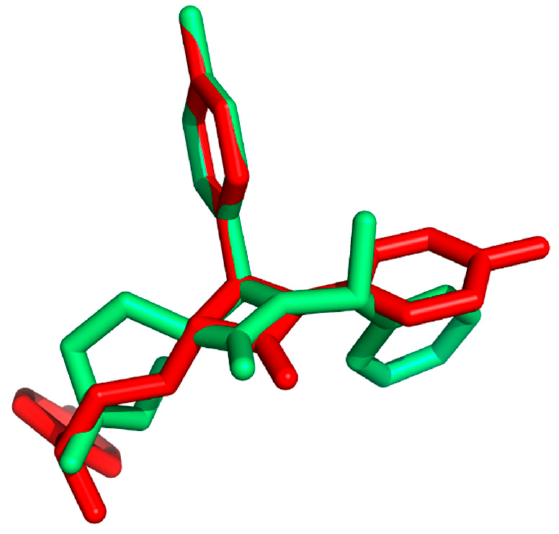
Figure 2. Representation of the structural overlap of Ezetimibe (red) and L1 (green).